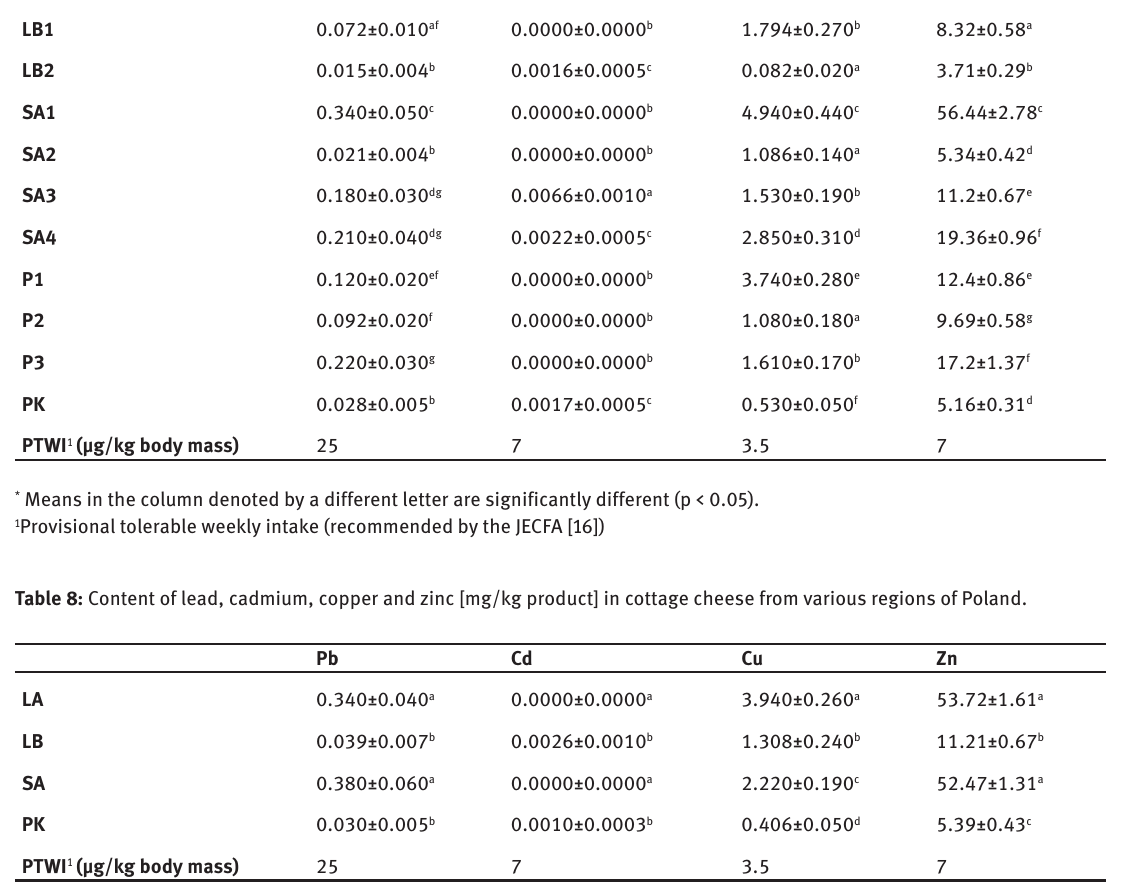
Table 7: Content of lead, cadmium, copper and zinc [mg/kg product] in cheese spreads from various regions of Poland. Pb Cd LA